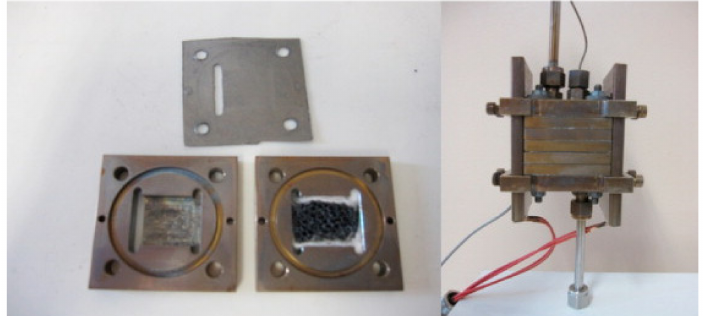
Figure 20. Photography of the complete reactor with five platelets with cover plates on each side with, gas entrance and exit, and thermocouple and the morphology of SiC with MoVNbTeO x catalyst. Adapted from ref. [131], Copyright (2012), with permission from Elsevier.